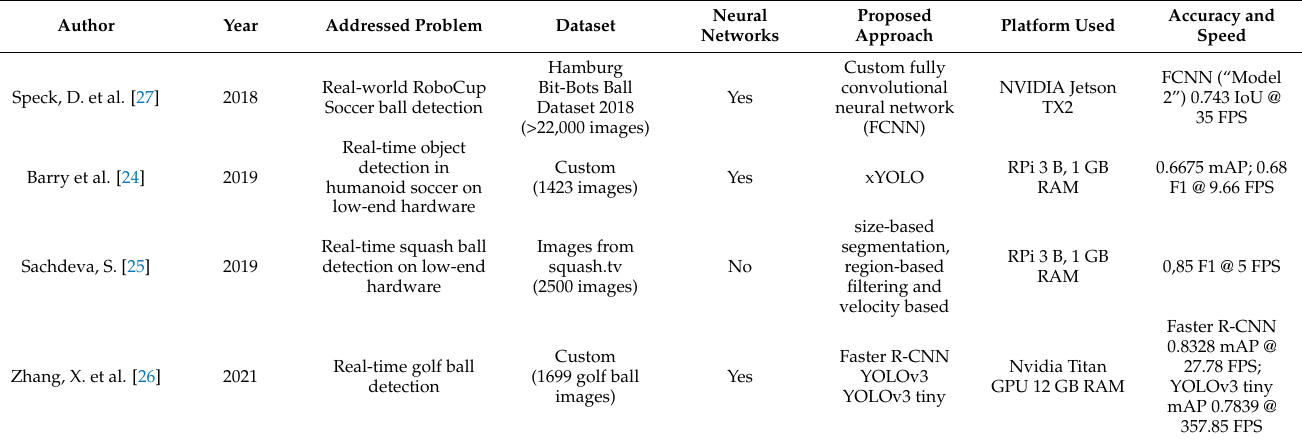
Table 1. Summary of related work on ball